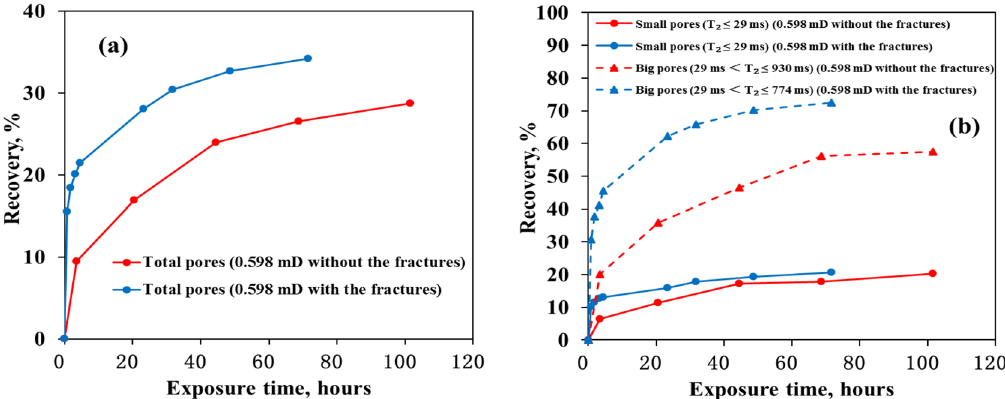
Figure 3. The relationships between recovery and exposure time for the cores with and without fractures: ( a ) total pores; ( b ) small pores and big pores.